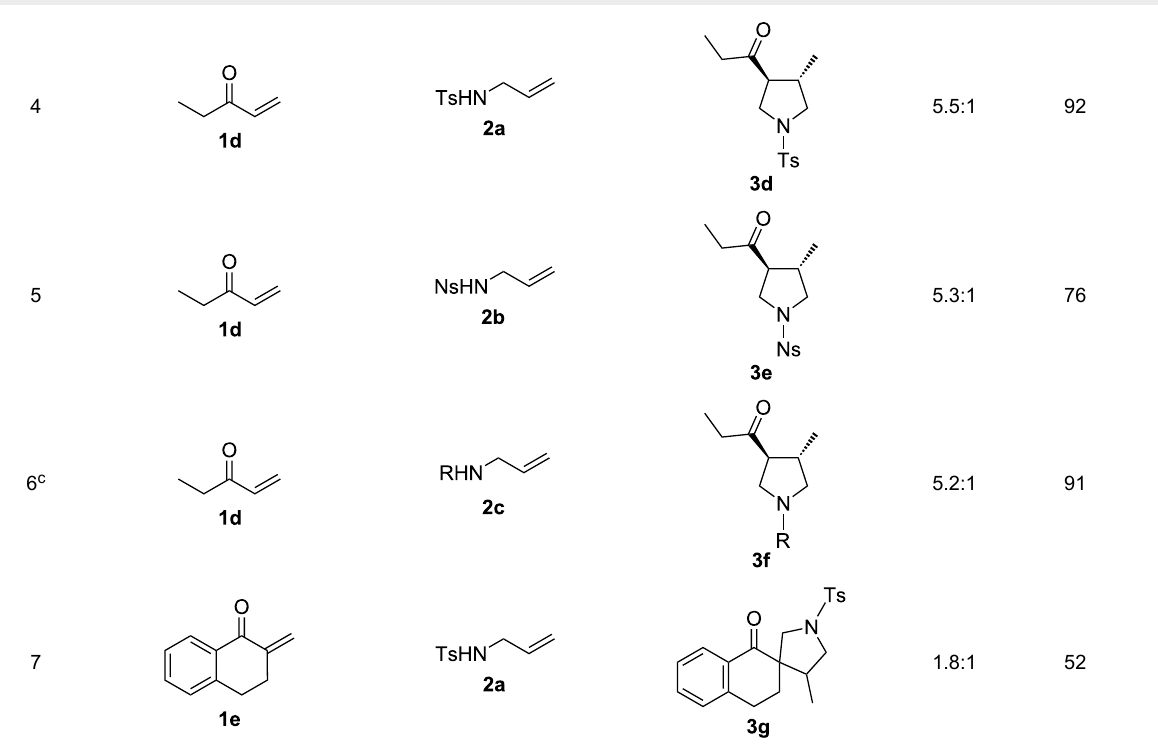
Table 3: Cascade synthesis of pyrrolidine catalyzed by a dual-metal catalytic system comprising of gold(I) and silver(I) catalysts.